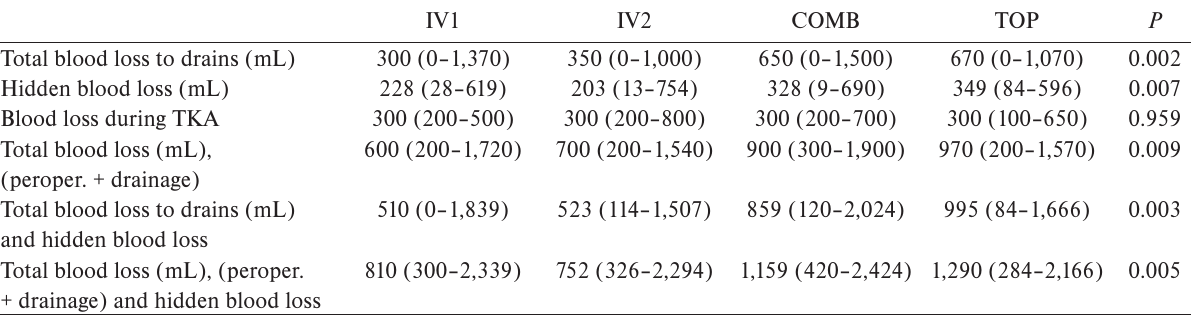
Table 4. Comparison of perioperative blood loss between patient TXA groups.